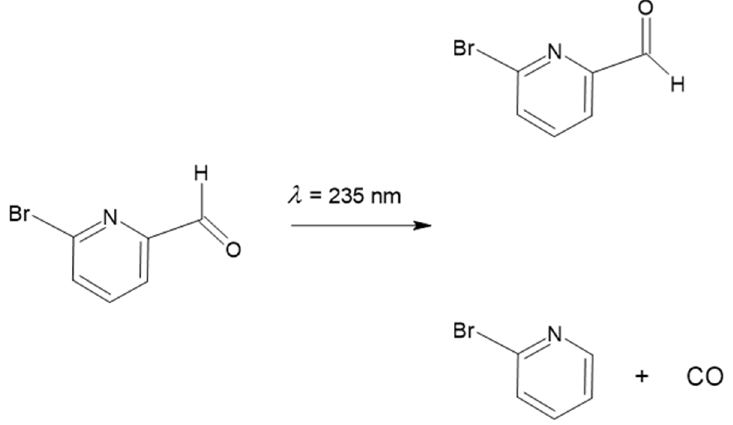
Figure 7. Summary of the observed photochemical processes for matrix-isolated BPCA upon irradiation at λ = 235 nm.